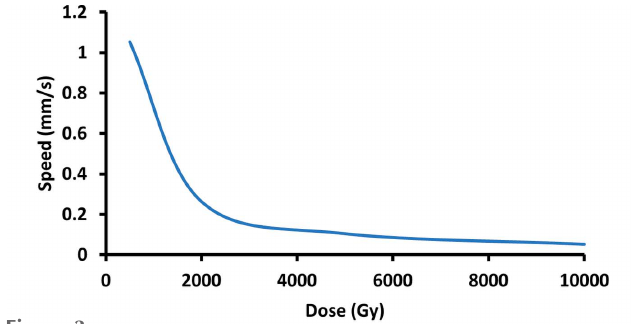
Figure 3 Relationship between the vertical speed of the sample (mm s (cid:2) 1 ) and delivered dose (Gy).